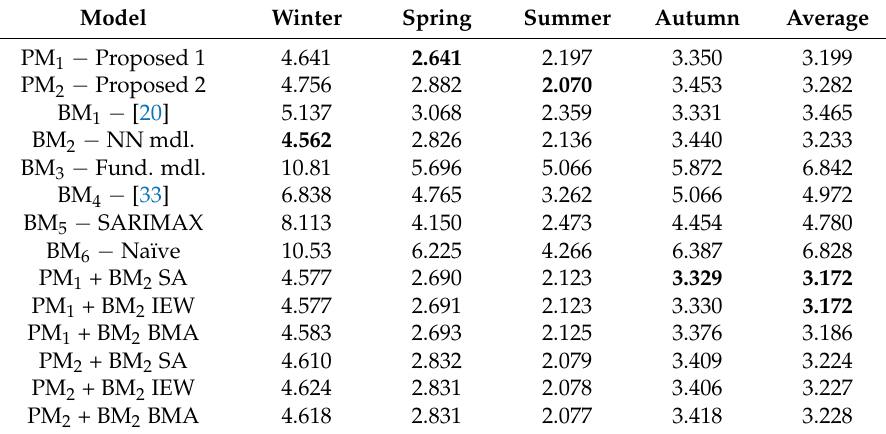
Table 4. Forecasting error in terms of MAE ( € /MWh).